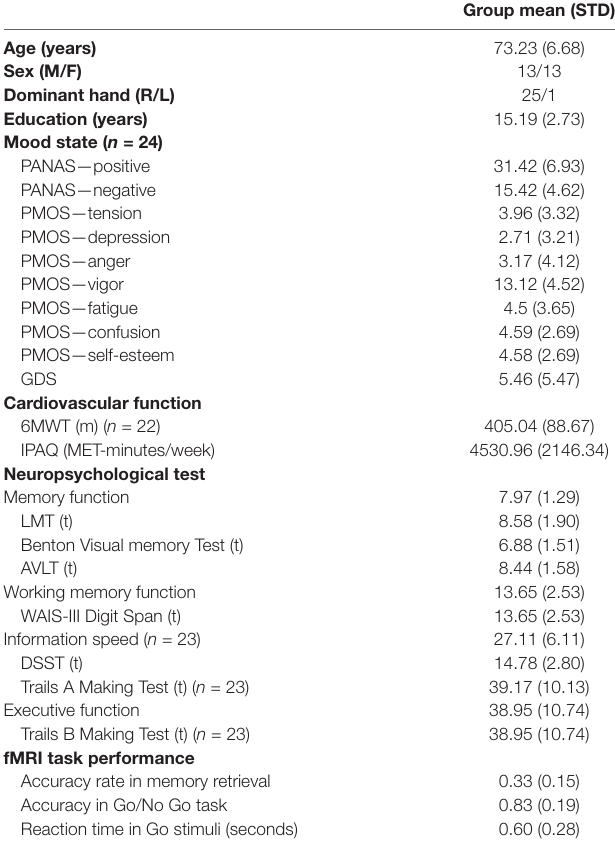
TABLE 1 | The demographic profile of participants and cognitive function at baseline ( n =